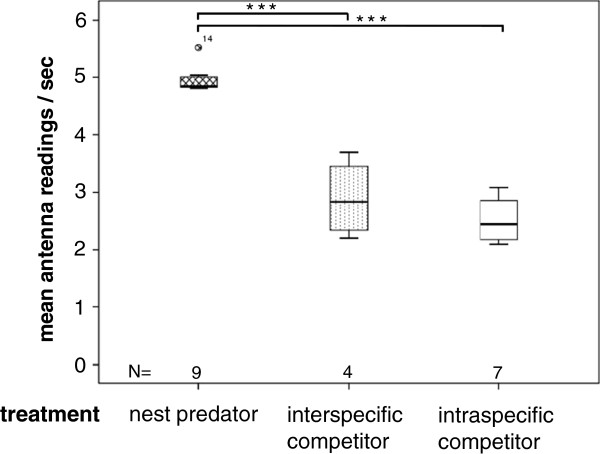
Vole mother’s (Microtus arvalis) time spent in their burrow entrances (during 36 hours). This variable was measured as mean number of antenna readings per second (possible maximum = 6 readings per second, indicating that the animal sits in the antenna ring; < 3 readings indicate a fast passage) in the presence of a nest predator (NP, shrew, Crocidura russula), a interspecific resource competitor (RC, field vole, M. agrestis), or a intraspecific competitor control individual (C). Data derived from circular antennas fixed at each burrow entrance connected to automatic transponder reading stations.